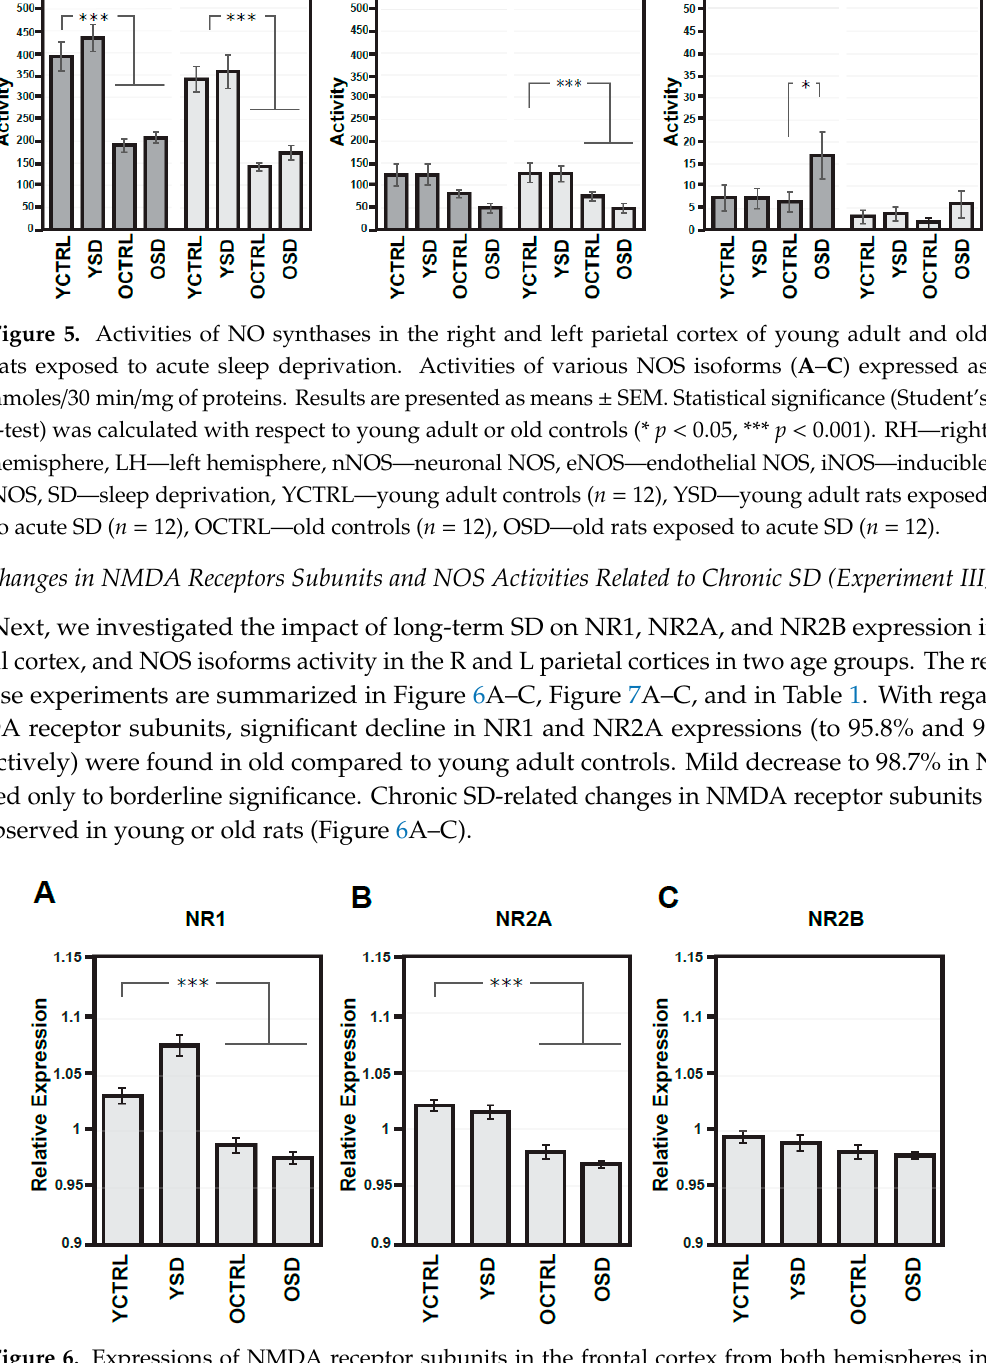
Figure 7. Comparison of activities of NO synthases in the right and left parietal cortex of young adult and old rats exposed to chronic sleep deprivation (experiment III). Summary histogram of activities of NOS isoforms ( A – C ) expressed as nmoles/30 min/mg of proteins. Results are presented as means ± SEM. Statistical significance (Student´s t -test) was calculated with respect to young adult controls (* p < 0.05, ** p < 0.01). RH—right hemisphere, LH—left hemisphere, nNOS—neuronal NOS, eNOS— endothelial NOS, iNOS—inducible NOS, SD—sleep deprivation, YCTRL—young adult controls ( n = 12), YSD—young adult rats exposed to chronic SD ( n = 12), OCTRL—old controls ( n = 12), OSD—old rats exposed to chronic SD ( n = 12). 2.4. Age-Dependent Changes in NMDA Receptors Subunits and NOS Activities (Experiments I–III) We analysed data of young adult and old controls from experiments I-III for age-dependent changes, with results summarized in Table 2. One-way ANOVA supported a significant drop in all subunit expressions (to 93.9% in NR1, to 96.3% in NR2A and finally to 96.9% in NR2B) and in some NOS isoforms activities (to 74.1% in the R side in nNOS, bilaterally to 62.3% and 63.4% in eNOS). In young adult controls, results of correlation analysis revealed significant links between particular subunits of the NMDA receptor (the positive link between NR1 and NR2A (CC = +0.668, p